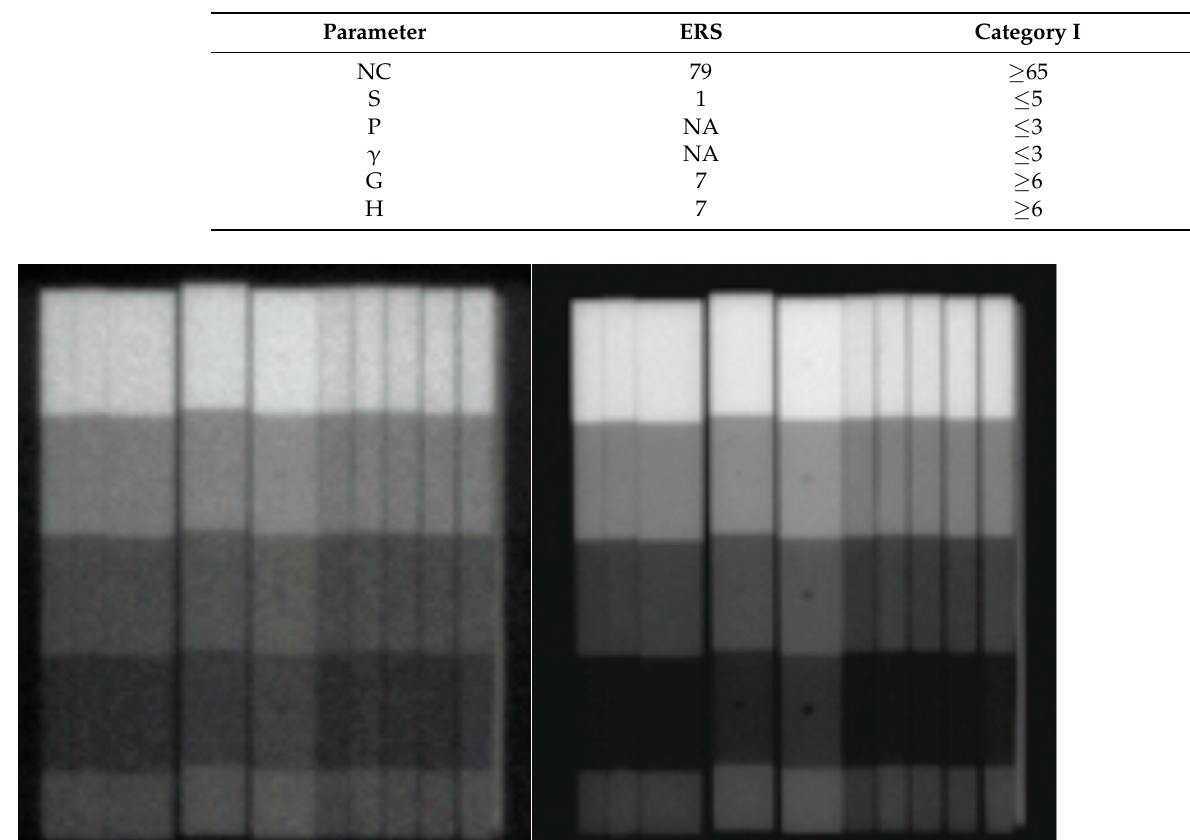
Table 8. Image quality indicator (IQI) measured values compared to a Category I facility.